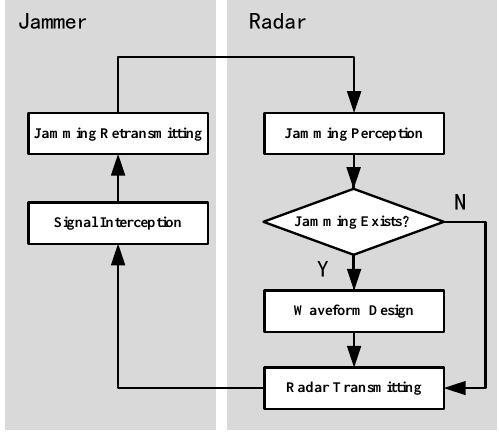
Figure 2. Flow chart of adaptive transmitting scheme.